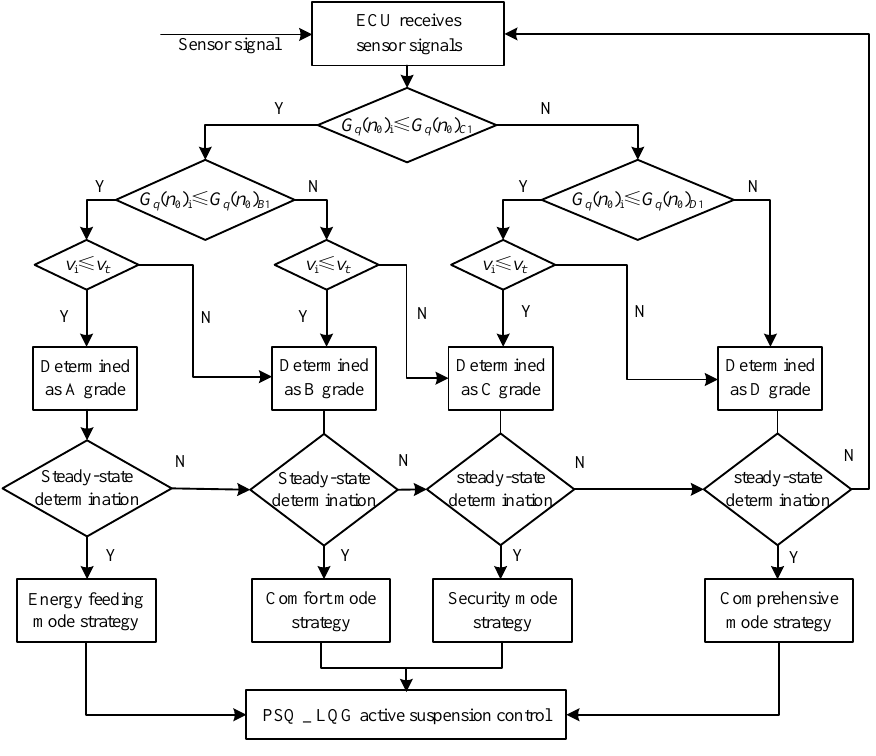
Figure 6. Function modules switching control flow.